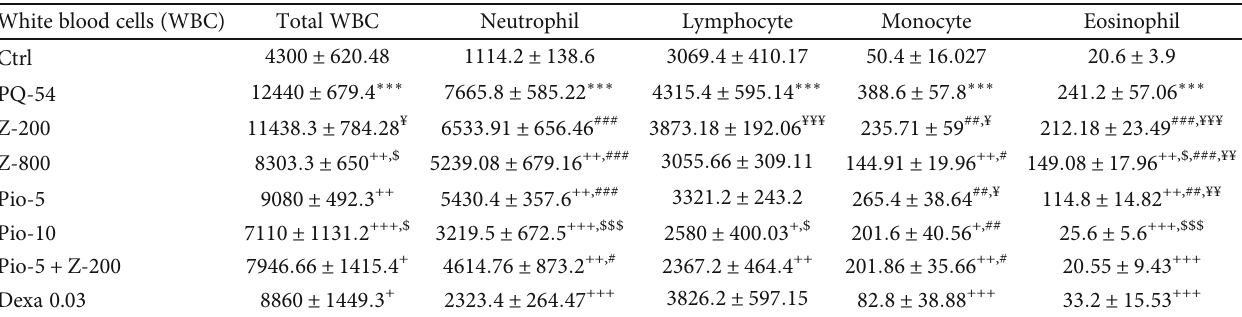
Table 1: Total and di ff erential WBC counts in the blood of control group (Ctrl), group exposed to paraquat aerosol at doses of 54 mg/m 3 (PQ- 54), groups exposed to PQ-54 mg/m 3 and treated with 5 and 10mg/kg/day pioglitazone, 200 and 800mg/kg/day Zataria multi fl ora , 0.03mg/kg/day dexamethasone, and 5mg/kg/day pioglitazone + 200 mg/kg/day Zataria multiflora (Pio-5, Pio-1, Z-200, Z-800, Dexa 0.03, and Pio ‐ 5 + Z ‐ 200 , respectively).